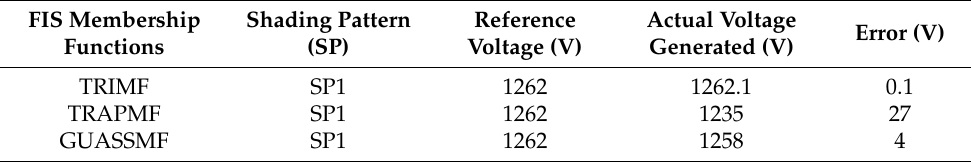
Figure 7. Reference voltage generation using various NF techniques. Table 2. Comparison of reference voltage prediction for various NF